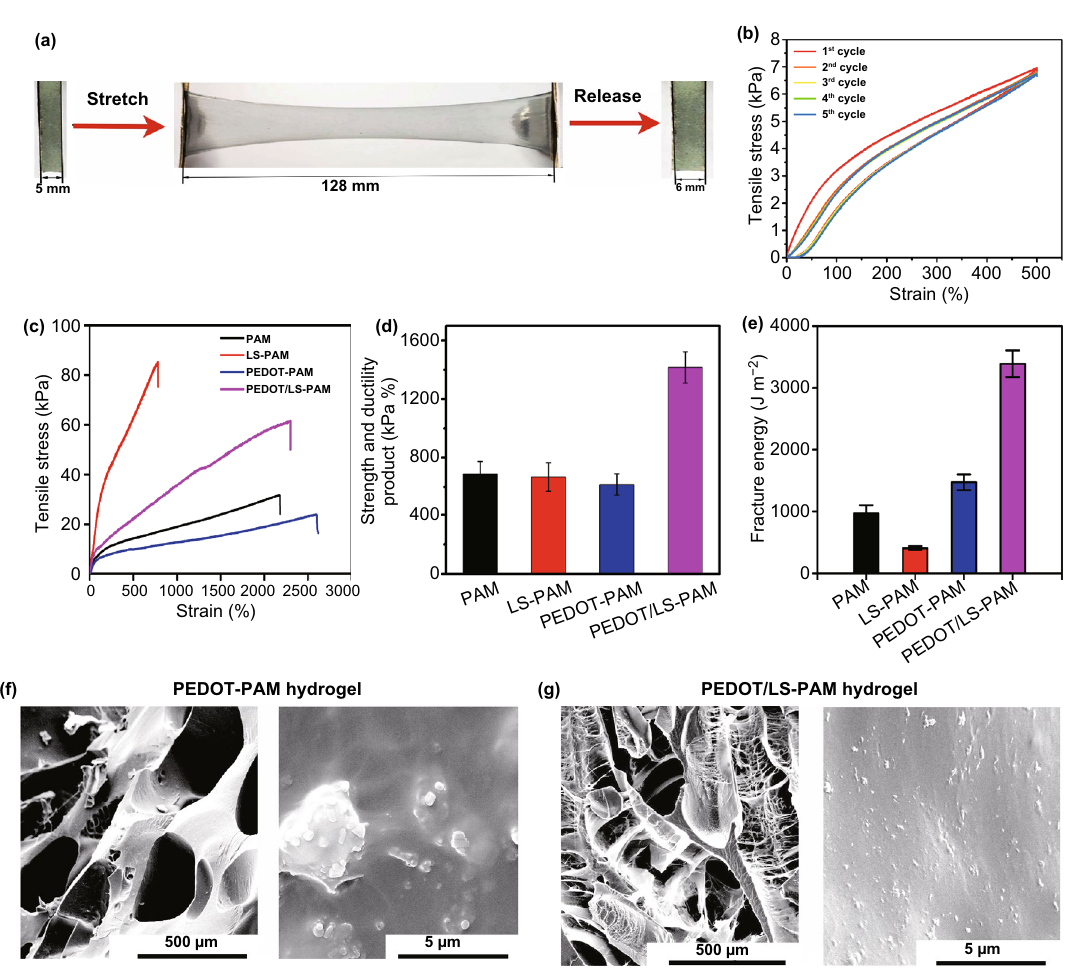
Fig. 6 Mechanical properties and microstructures of hydrogels. a PEDOT/LS-PAM hydrogel with 3 wt ‰ of PEDOT/LS NPs was elongated to 25.6 times of its initial length and recovered. b Cyclic tensile loading–unloading curves of the PEDOT/LS-PAM hydrogel. Typical tensile stress–strain curves of c various hydrogels and d hydrogels with different contents of PEDOT/LS NPs. e Fracture energy of various hydrogels. Morphologies and magnified images of freezing dried hydrogels. f PEDOT-PAM hydrogel, and g PEDOT/LS-PAM